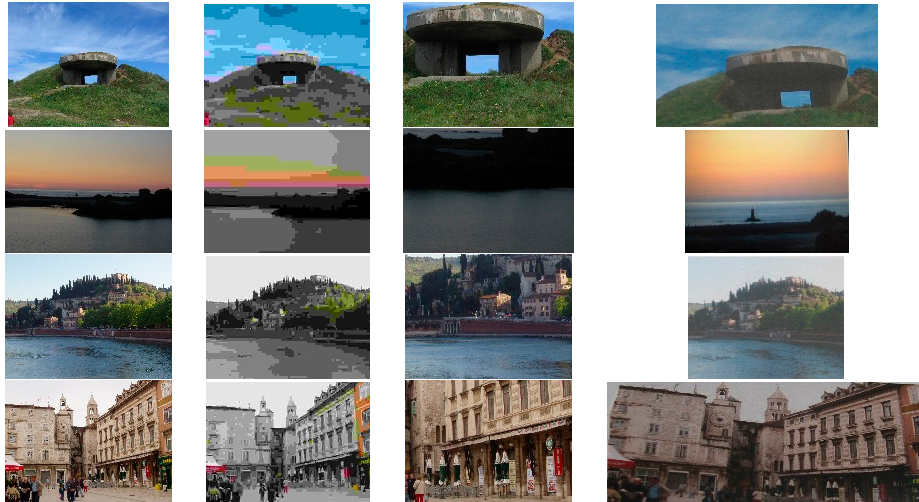
Figure 1. The toy examples of an original image and its copies. The left column is the original image, and the right three columns correspond to the copy versions generated by three different kinds of attacks, which are JPEG compression; cropping; and the combination of several manipulations, such as rotation, cropping, noise addition, and screen-shooting.